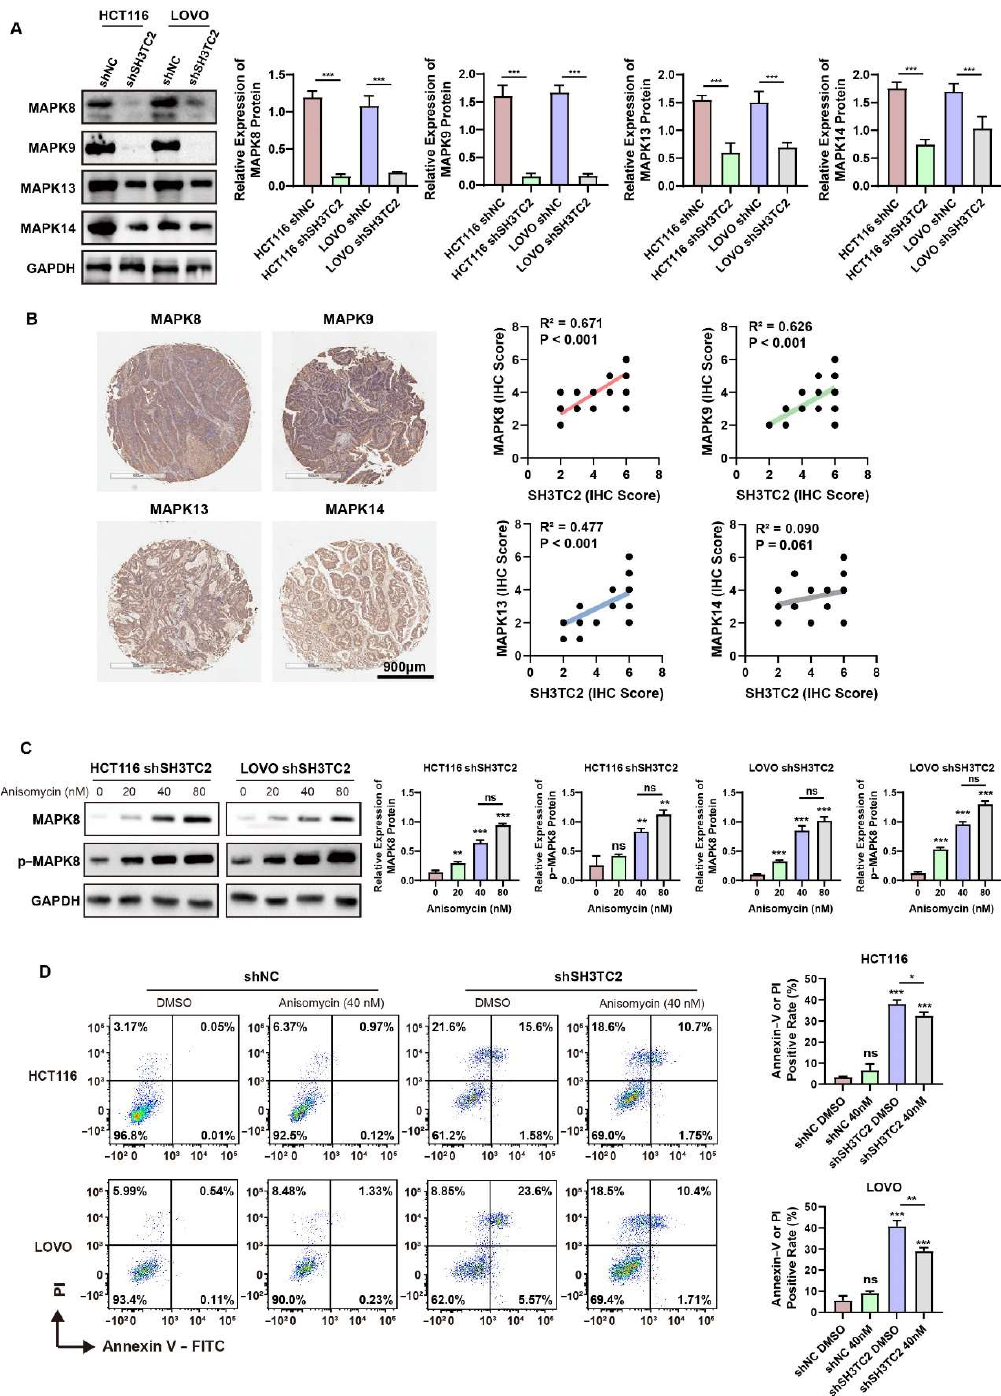
Figure 6. SH3TC2 knockdown regulates cell apoptosis via MAPK pathway. ( A ) Western blot analysis implied that MAPK8, 9, 13, and 14 were significantly inhibited after the stable knockdown of SH3TC2. ( B ) Analysis of clinical samples implied that expression of SH3TC2 was positively correlated with MAPK 8, 9, and 13. However, no statistical significance was found for MAPK14. ( C ) The implementation of MAPK8 activator significantly upregulated MAPK8 and p−MAPK8. ( D ) The res- marked specially, statistical analysis was compared to the blank or control group: ns, not significant; * p < 0.05; ** p < 0.01; *** p < 0.001.